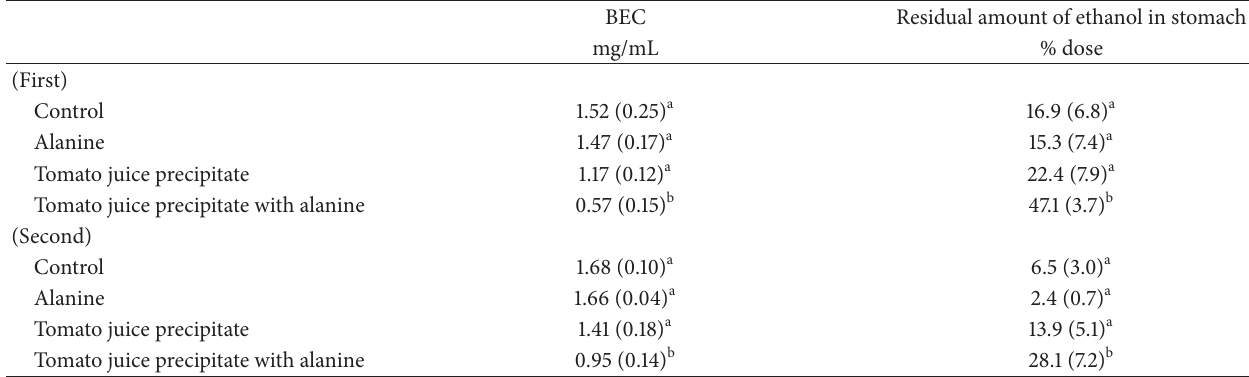
Table 1: Blood ethanol concentration and residual ethanol in the stomach 2 h after the administration of 2.0 g/kg of ethanol in Experiment 3 .